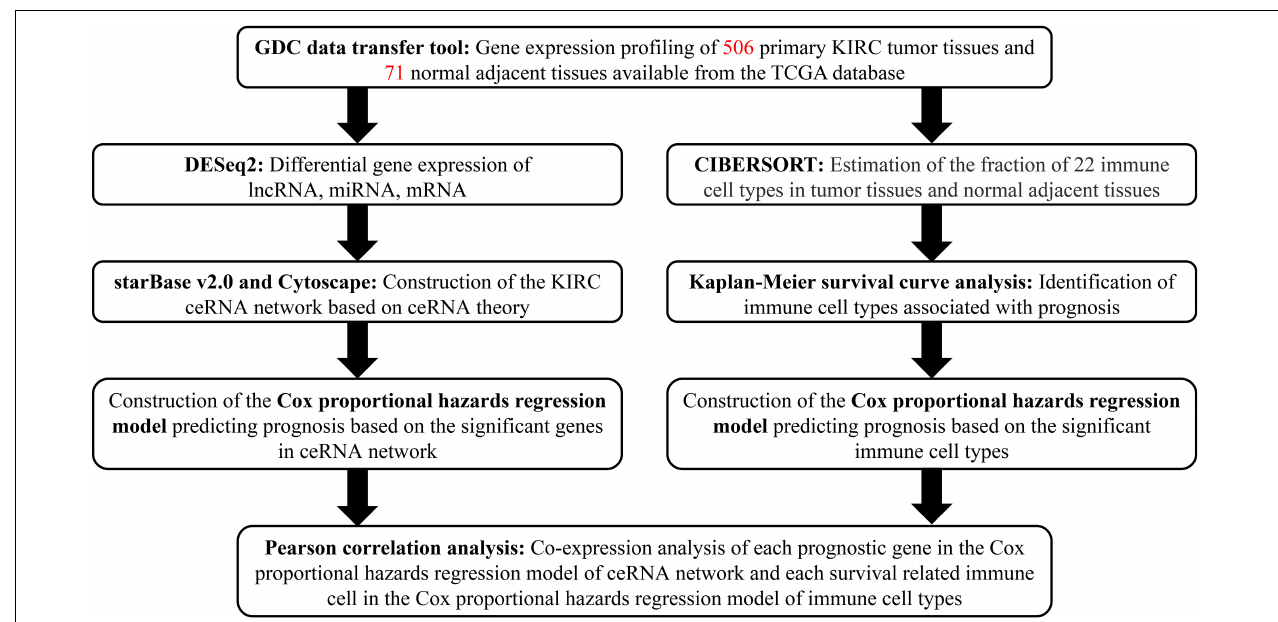
FIGURE 1 | Flowchart of the analysis